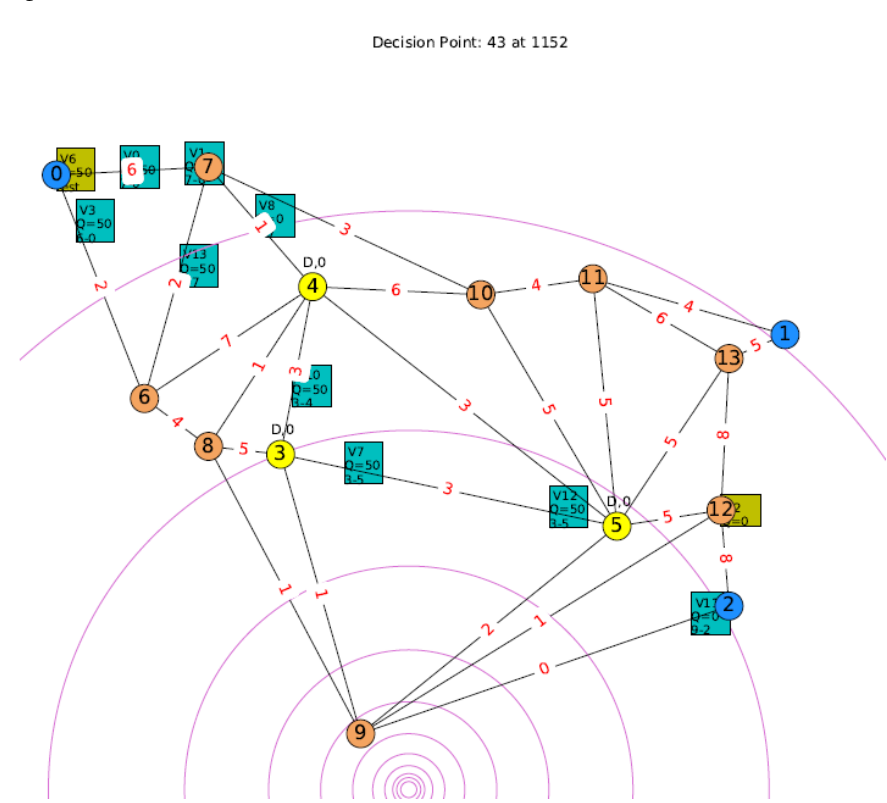
Figure A3. Road Network for Instance D5N13S5.